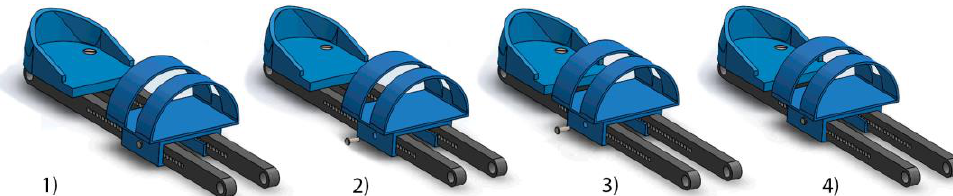
Figure 3. The mechanism that makes the robot easy to fit and remove.